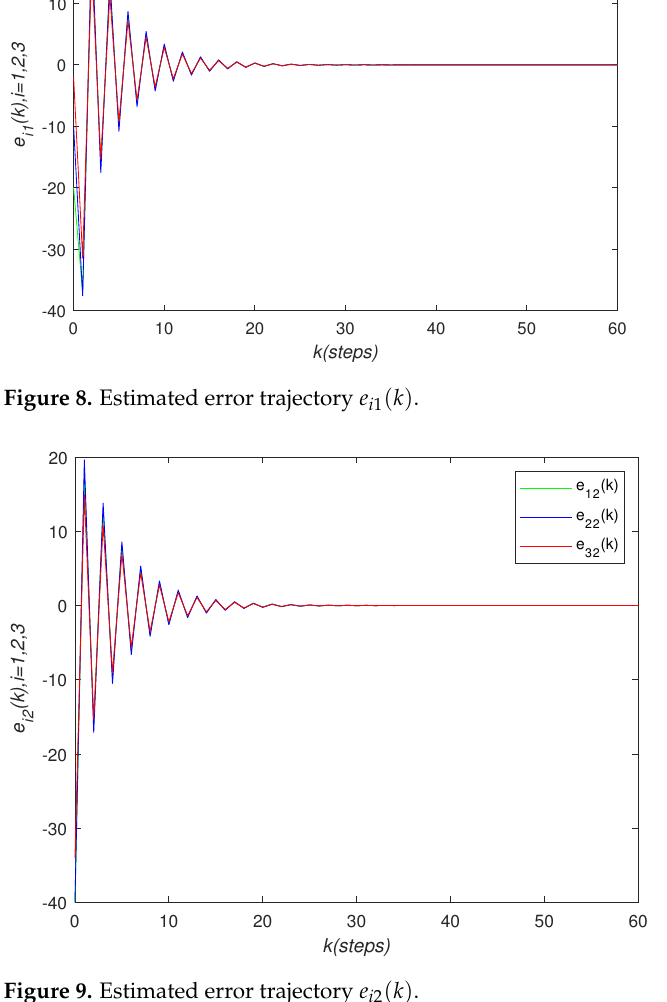
Figure 9. Estimated error trajectory e i 2 ( k ) .